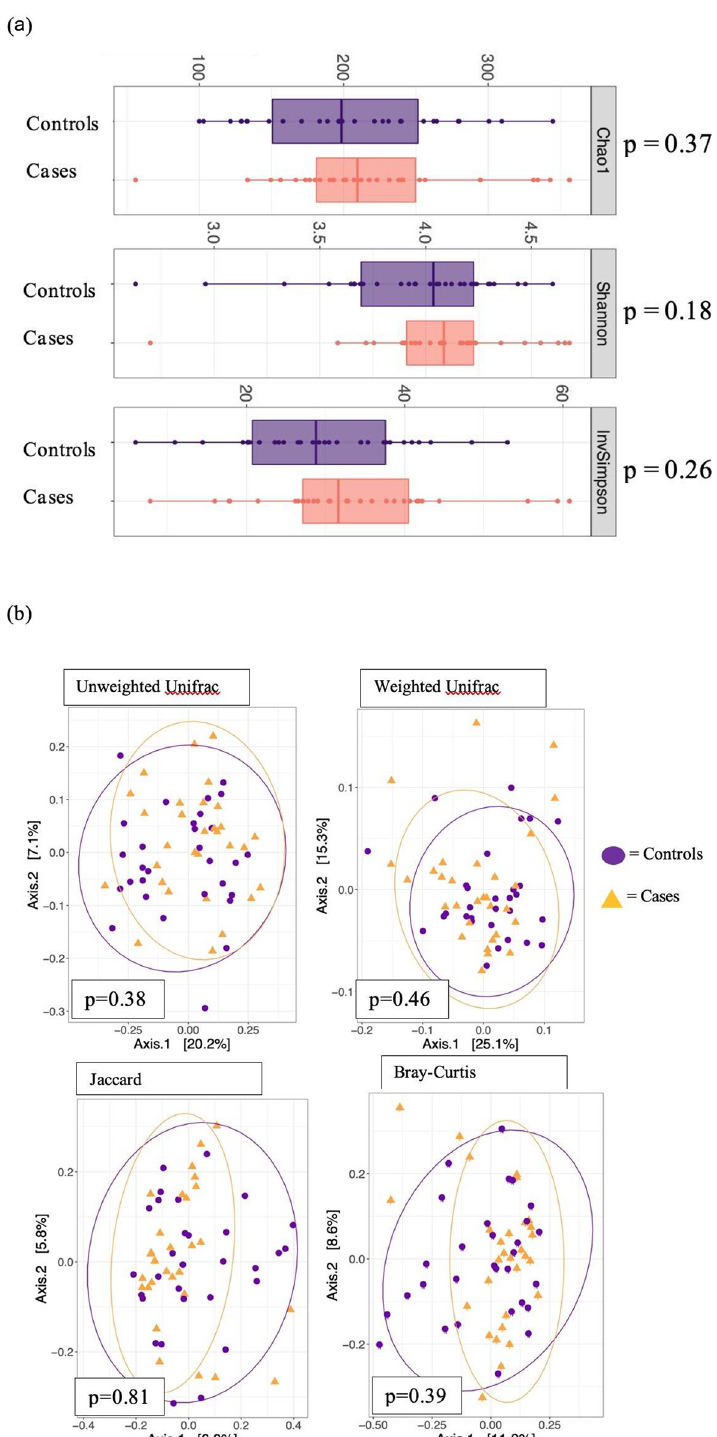
Fig 1. Alpha and beta diversity by case-control status. (a) Alpha diversity metrics by case control status—Chao1, Shannon, and Inverse Simpson (b) Beta diversity metrics by case control status–PCoA plots of normalized Unifrac distances, unweighted (p = 0.38) and weighted (p = 0.46), Jaccard index (p = 0.81), and Bray-Curtis index (p = 0.39). p values correspond to between-group comparisons using PERMANOVA. p < 0.05 is statistically significant. Cases = yellow triangles and controls = purple circles. Abbreviations: MCI—Mild Cognitive Impairment.